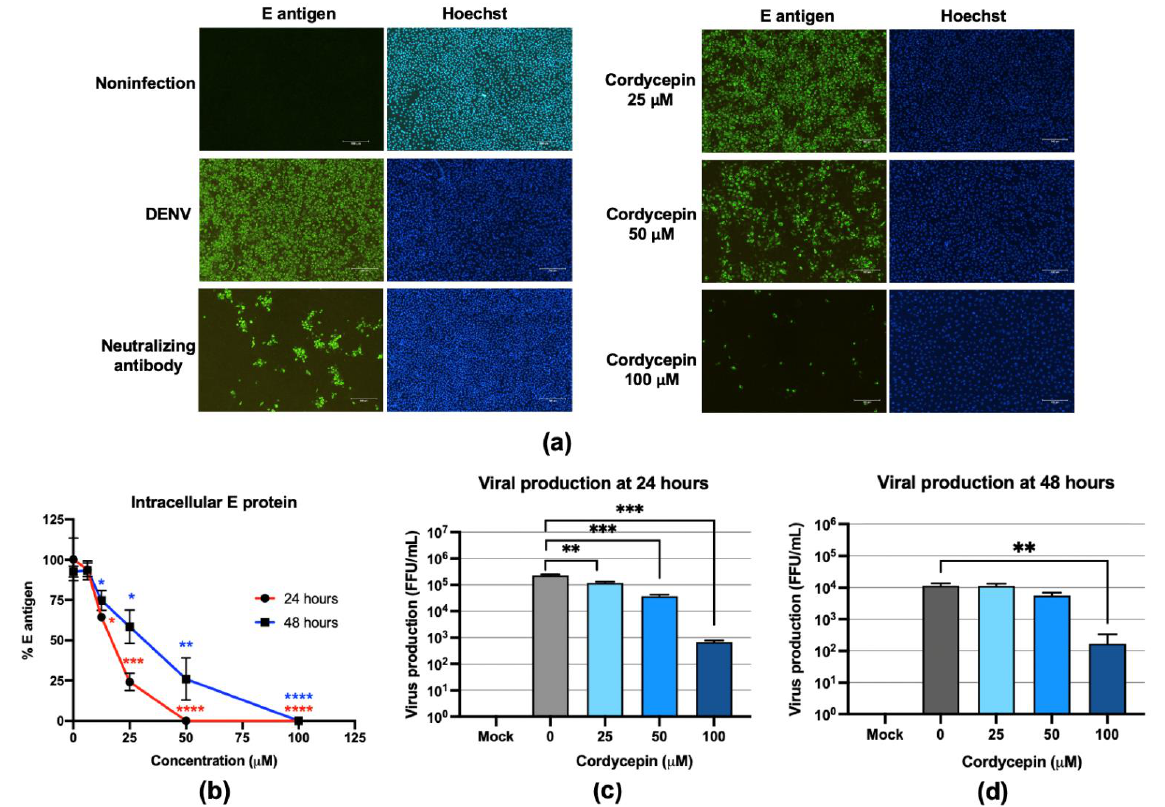
Figure 2. The inhibitory effects of cordycepin on DENV2-infected Vero cells, envelope (E) protein levels, and virus production in cell culture supernatants. ( a ) The numbers of DENV2-infected cells after treatment with cordycepin at concentrations of 25, 50, and 100 μM were examined 48 h postinfection by immunofluorescence assay (IFA). The DENV2 E protein was stained in green, and the nucleus was stained in blue. ( b ) The intracellular DENV2 E protein was examined by cell-based enzyme-linked immunosorbent assay (ELISA) 24 and 48 h after infection and cordycepin treatment. ( c , d ) DENV2 production in cell culture supernatants 24 and 48 h after infection and cordycepin treatment was determined by focus-forming assay. (* indicates p < 0.05; ** indicates p < 0.01; *** indicates p < 0.001, and **** indicates p < 0.0001.)